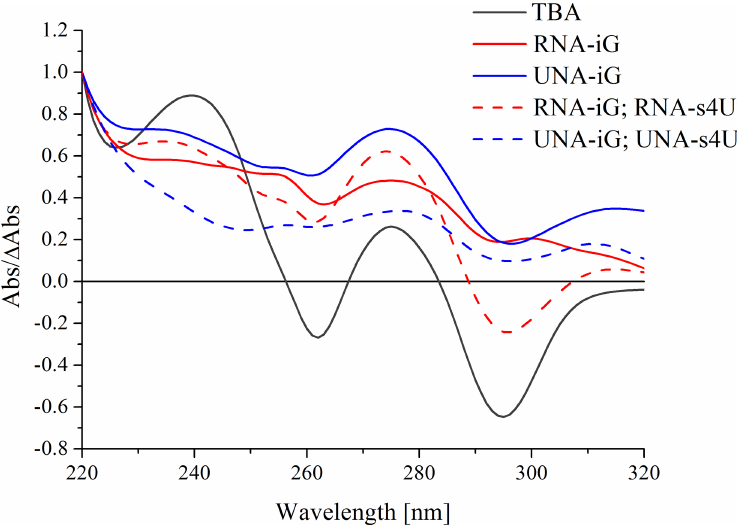
Fig 4. Representative thermal difference spectra of TBA (black, solid line), and TBA variants substituted by RNA- iG (red, solid line), UNA-iG (blue, solid line), RNA-iG and RNA-s4U (red, dashed line), UNA-iG and UNA-s4U (blue, dashed